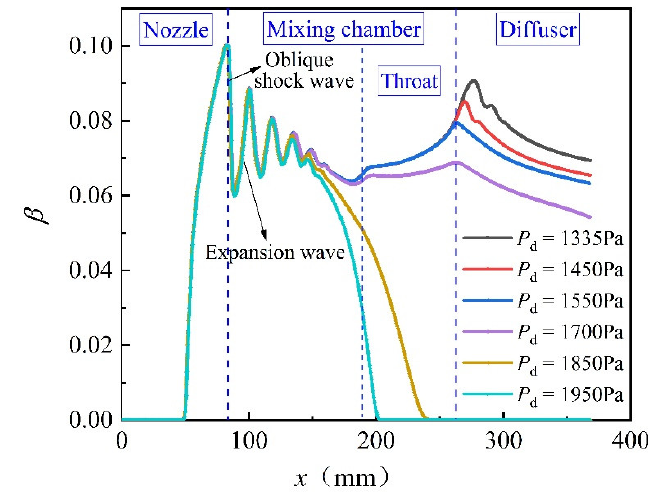
Figure 6. Condensate mass fraction profiles of the axis with different P d .